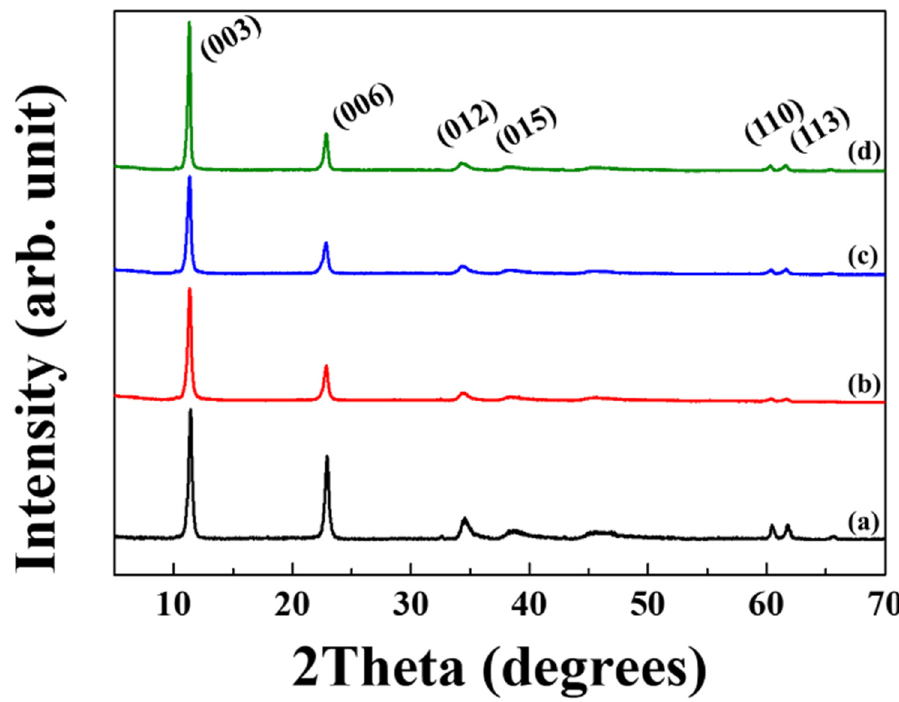
Figure 2. Powder X-ray diffraction patterns of (a) parent MgAl-layered double hydroxide (LDH), (b) Ga@LDH-0.5 (c) Ga@LDH-2, and (d) Ga@LDH-24.